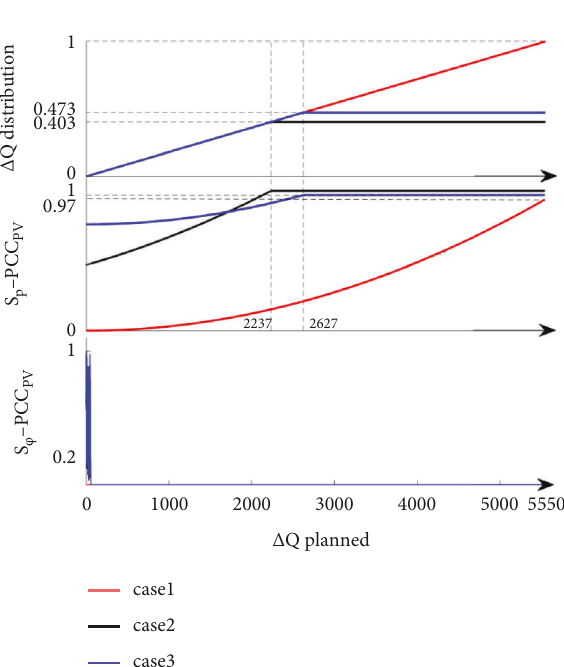
Figure 4: The results of algorithm 1 for the case.